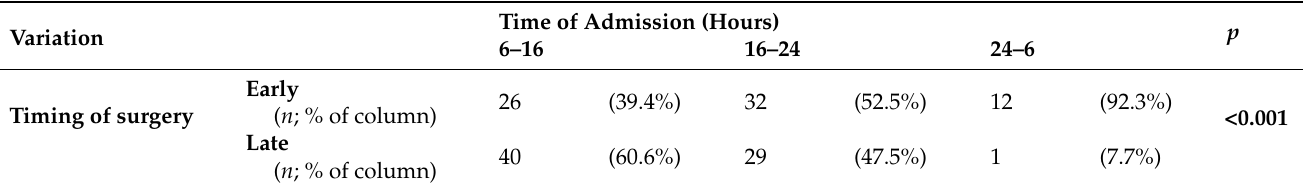
Table 4. Patients with acute MSCC: Timing of surgery in relation to time of admission to hospital. Bold typeface denotes statistically significant difference.